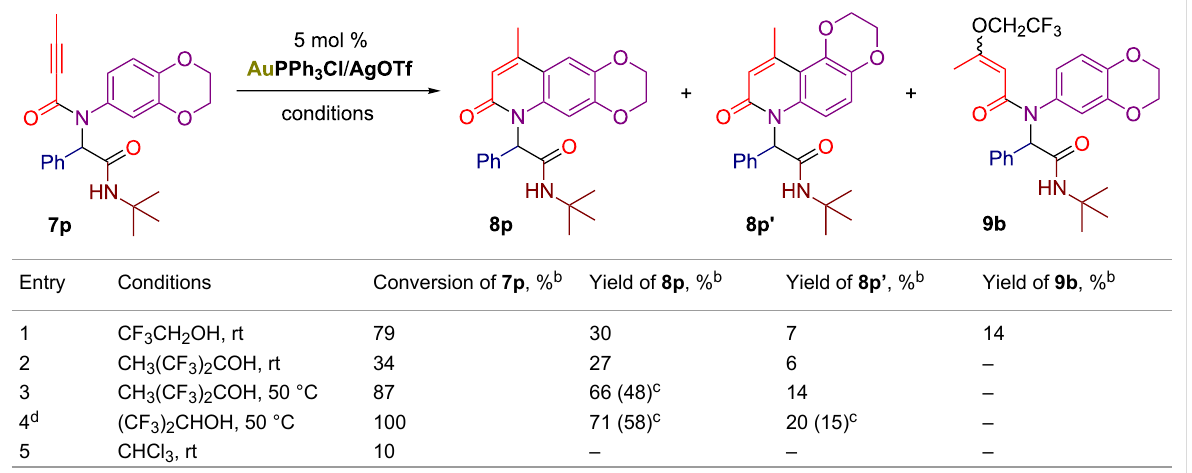
Table 2: Screening the conditions for the gold-catalyzed intramolecular hydroarylation of the Ugi adduct 7p . a